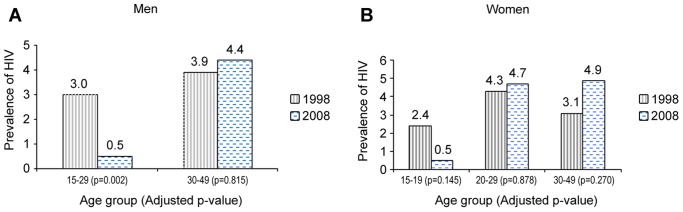
Multivariate comparison by age group of HIV prevalence between 1998 and 2008 among men and women, general population of Cotonou, Benin.P-values are from Wald chi-square test from multivariate logistic models (taking into account the cluster affect and adjusting for marital status). There is a significant decline in HIV prevalence in men aged 15–29 years and a non-significant decrease among women aged 15–19 years. Irrespective of gender, there is a non-significant increase in HIV prevalence in all the other age groups. There were too few HIV-infected men aged 15–19 years in both studies (zero in 1998 and only one in 2008) to further break down the 15–29 age group among men.